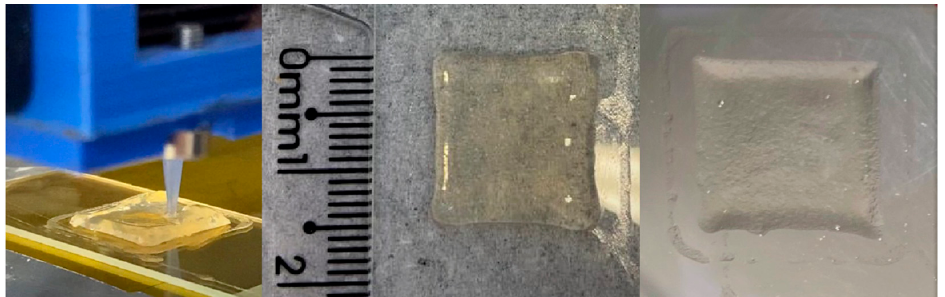
Figure 7. 3D-printed film (sample F-HG). From left to right: 3D printing during extrusion; 3D-printed film before drying; 3D-printed film after drying.